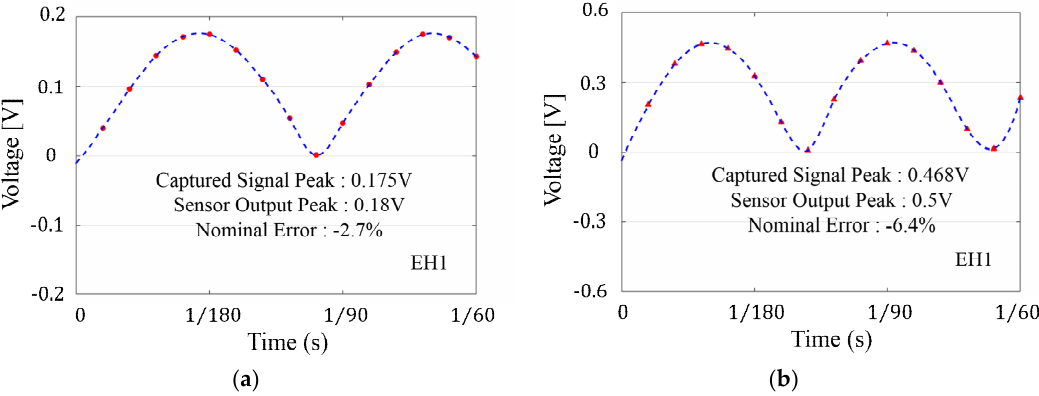
Figure 10. ( a ) Captured ADC values for a 60 Hz, 0.36 V peak-peak signal ( b ) Captured ADC values for a 60 Hz, 1.0 V peak-peak signal. Transmitted ADC values (red dots) for two arbitrary signal inputs to the wireless sensor node (with 15 positive points representing a full cycle of the sensor’s sinusoidal signal). The blue dashed curve shows the fitting result of the sensor’s signal with absolute